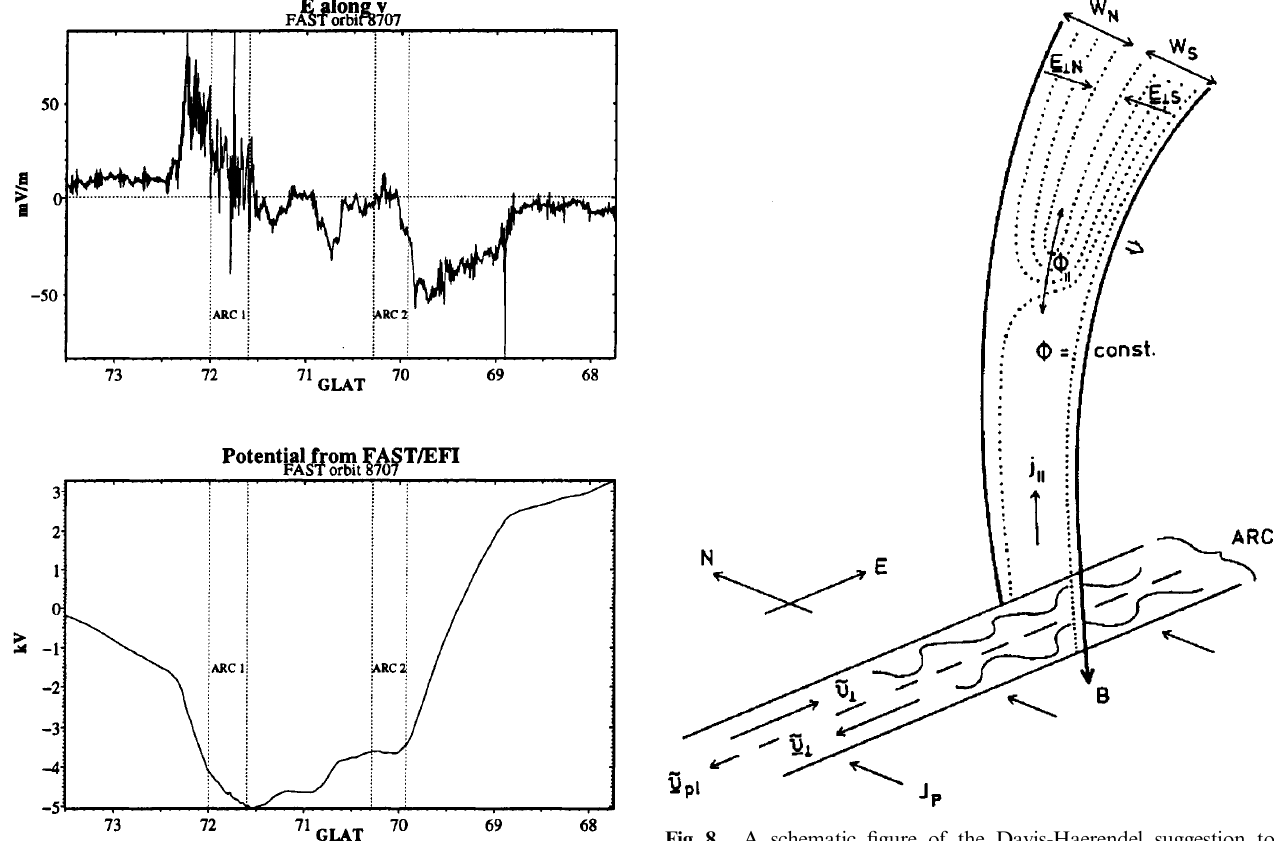
Fig. 8. A schematic figure of the Davis-Haerendel suggestion to explain the high speed of east-west undulations which propagate along the edges of an arc (reproduced from Haerendel et al., 1996, Fig. 8)